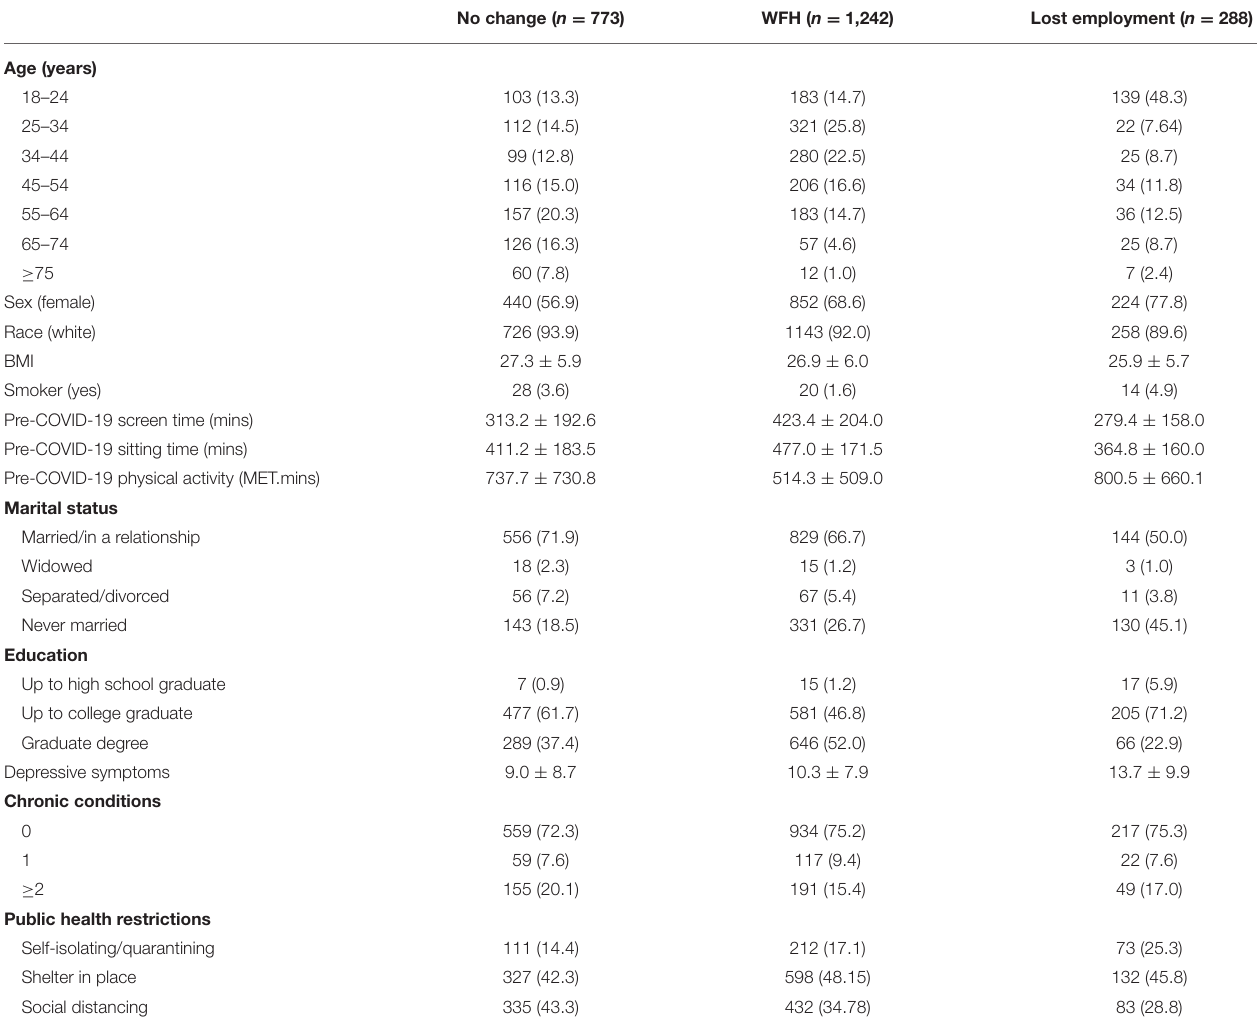
TABLE 1 | Participant characteristics by COVID-19-related changes in